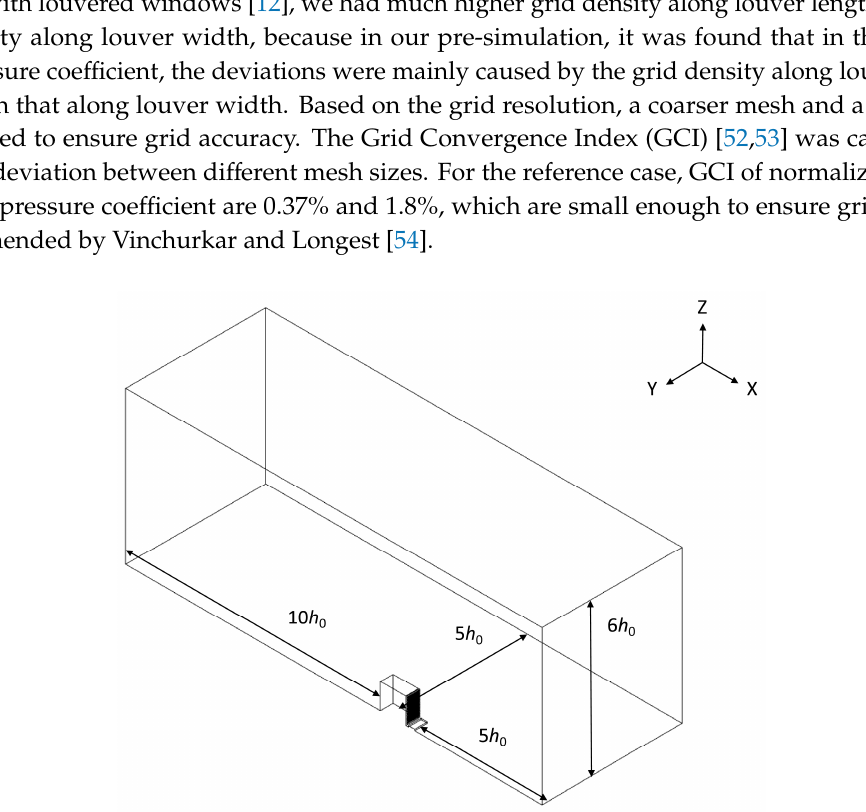
Figure 6. Dimensions of the computational domain for CFD